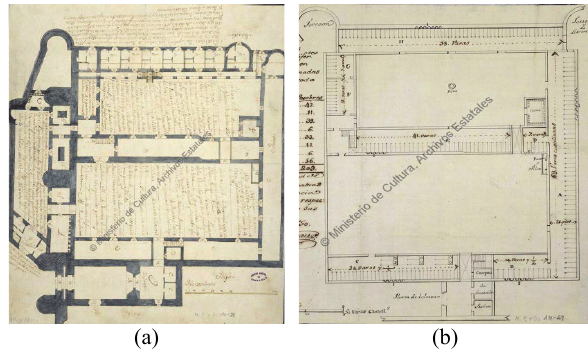
Figure 1. Different historical sources employed. (a) Juan Gómez Parral, 1749 (AGS. MPD, 14, 028). (b) Pedro Moreau, 1750 (AGS. MPD, 14, 029). Source: National Archive of Simancas (Spain).